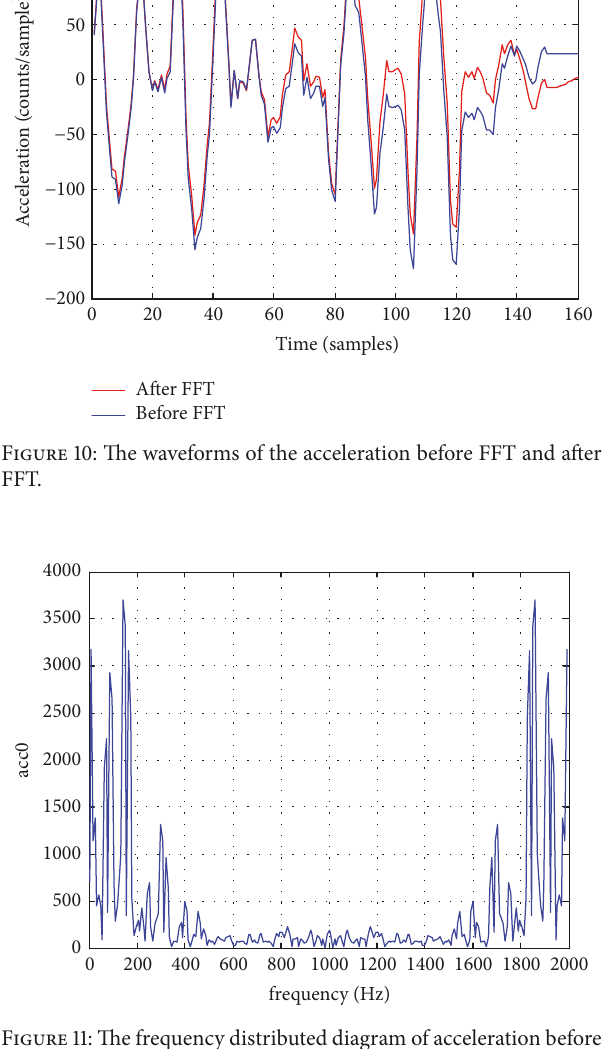
Figure 11: The frequency distributed diagram of acceleration before FFT.